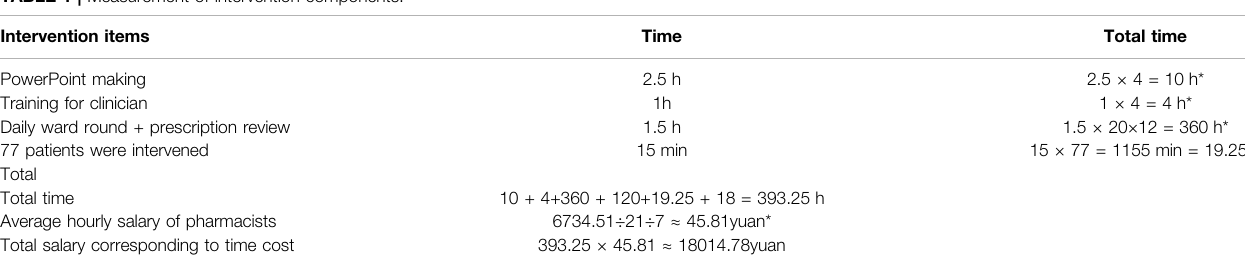
TABLE 1 | Measurement of intervention